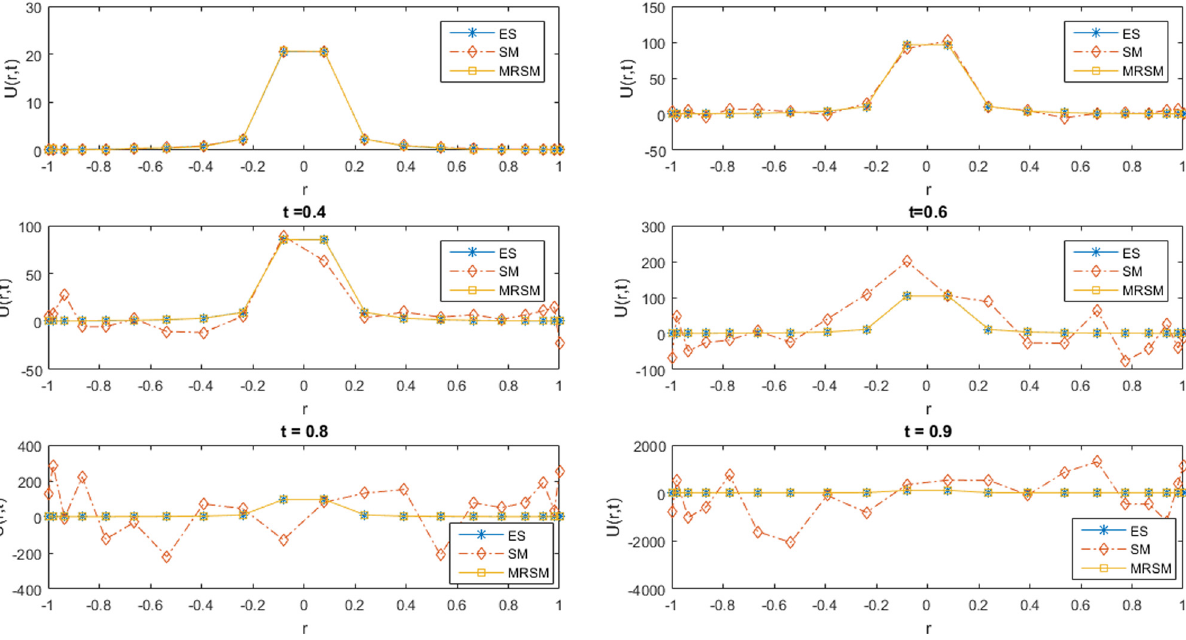
Figure 7: ES and behaviors of SM and MRSM for Example 4.2 for r −1, 1 [ ] ∈ with M 20 = and various times t 0.1, 0.2, 0.4, 0.6, 0.8 = and